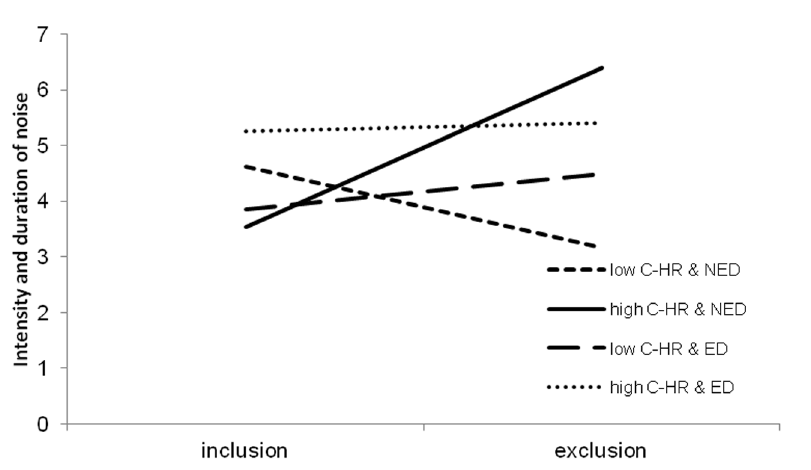
Figure 1. Interaction effect of exclusion, ego-depletion (ED; NED, no ego-depletion) and C-HR on displaced aggression. Slopes are plotted at the ±1